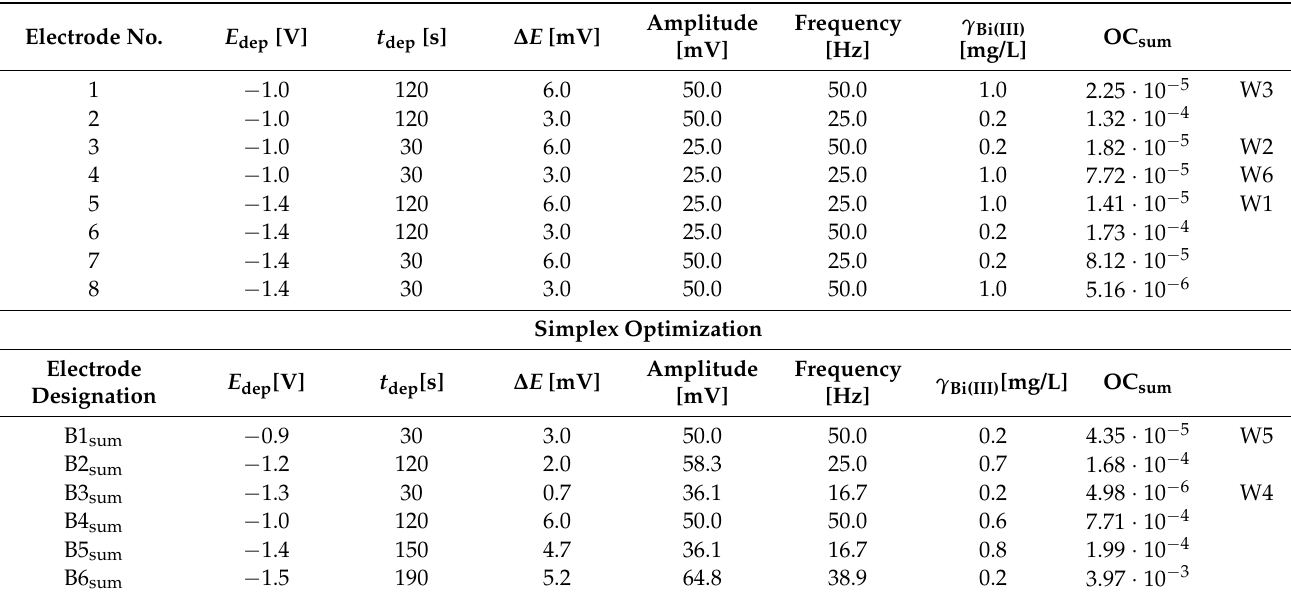
Table 5. The simplex optimization procedure with designated Wi and Bi, when OC sum is taken as the OC.